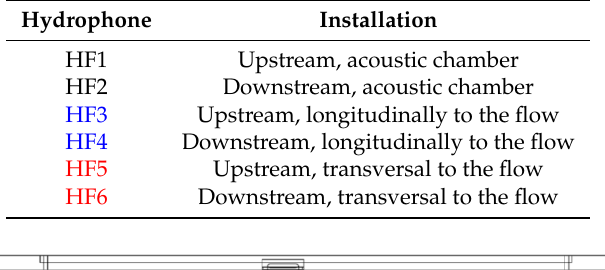
Table 3. Hydrophone arrangements in the cavitation tunnel.